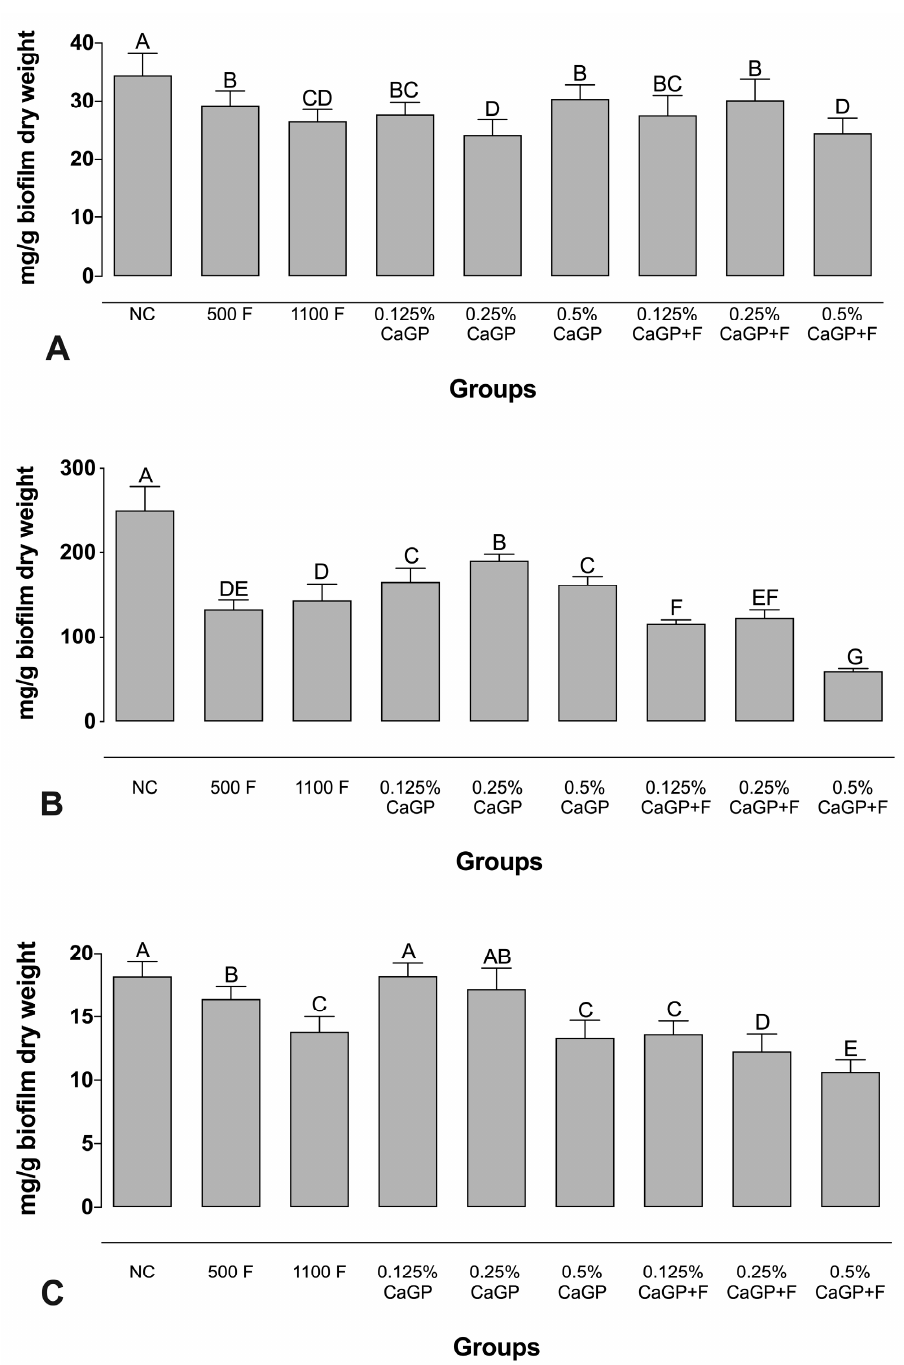
Figure 1. Mean values of ( A ) Protein, ( B ) Carbohydrate, and ( C ) Nucleic acids from the extracellular matrix of dual-species biofilms obtained after treatment with different concentrations of CaGP, with or without an association with F. Error bars denote the standard deviations of the means. Different upper-case letters symbolize statistical differences among the groups (1-way ANOVA, Fisher’s LSD test, p < 0.05; n = 9). NC: negative control (untreated biofilms); CaGP: calcium glycerophosphate; F: fluoride.